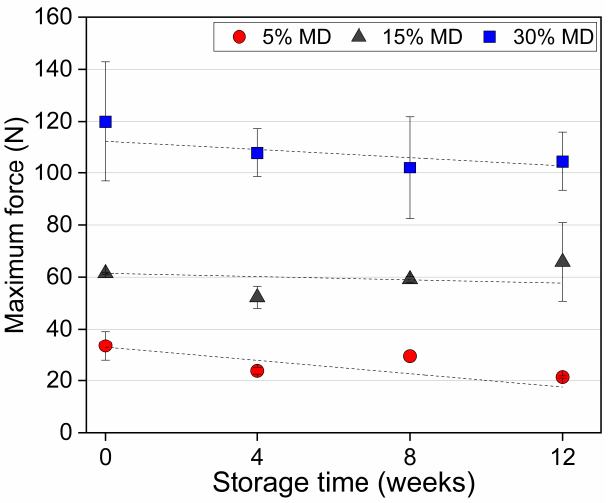
Figure 5. The maximum force (as a measure of sample hardness) of dried raspberry foam samples with 5% ( w / w ) PP + 2.5% ( w / w ) P at various MD concentrations. The hardness value was defined as the maximum peak force of the food matrix